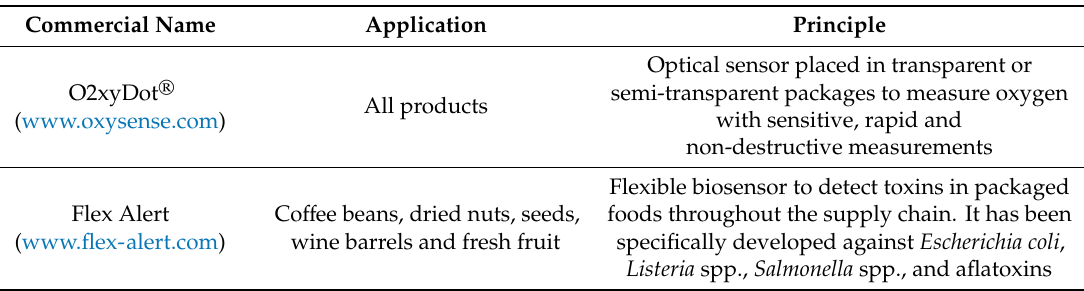
Table 7. Commercially available